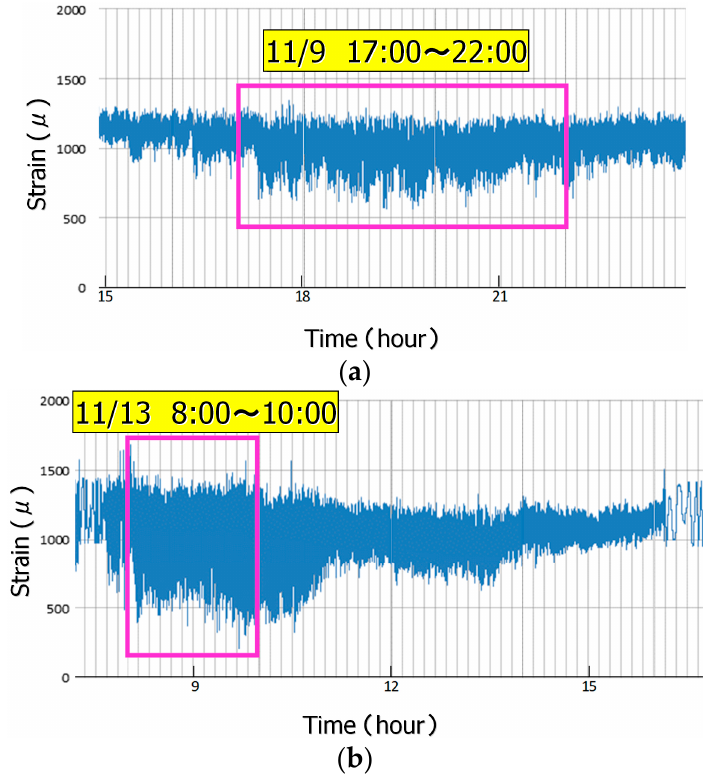
Figure 12. Blade strain data (blade flapwise bending raw data). ( a ) Northerly wind. ( b ) Easterly wind. Note: interval: 0.02 seconds, average wind speed: approx. 9 m/s.